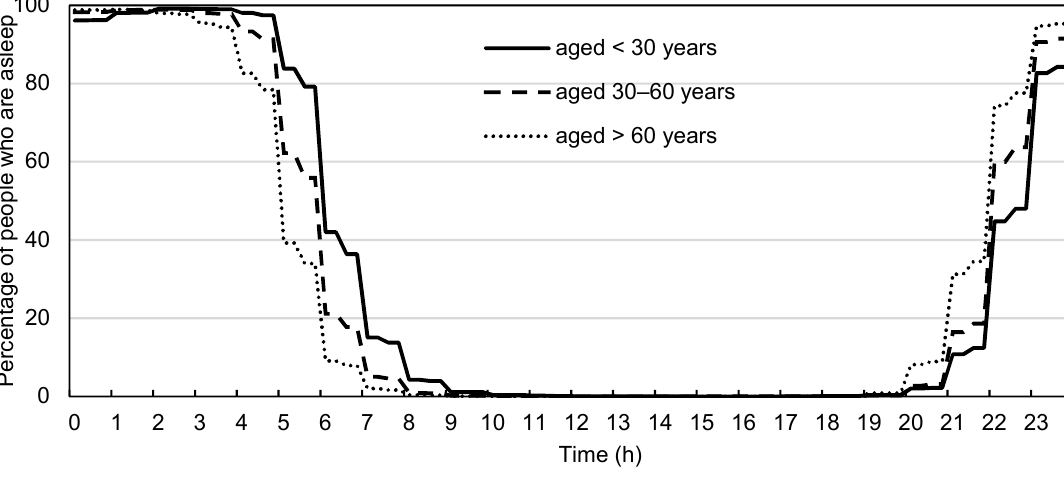
Figure 7. Age di ff erences in Vietnamese people’s sleeping time on Figure 7. Age differences in Vietnamese people’s sleeping time on weekdays.